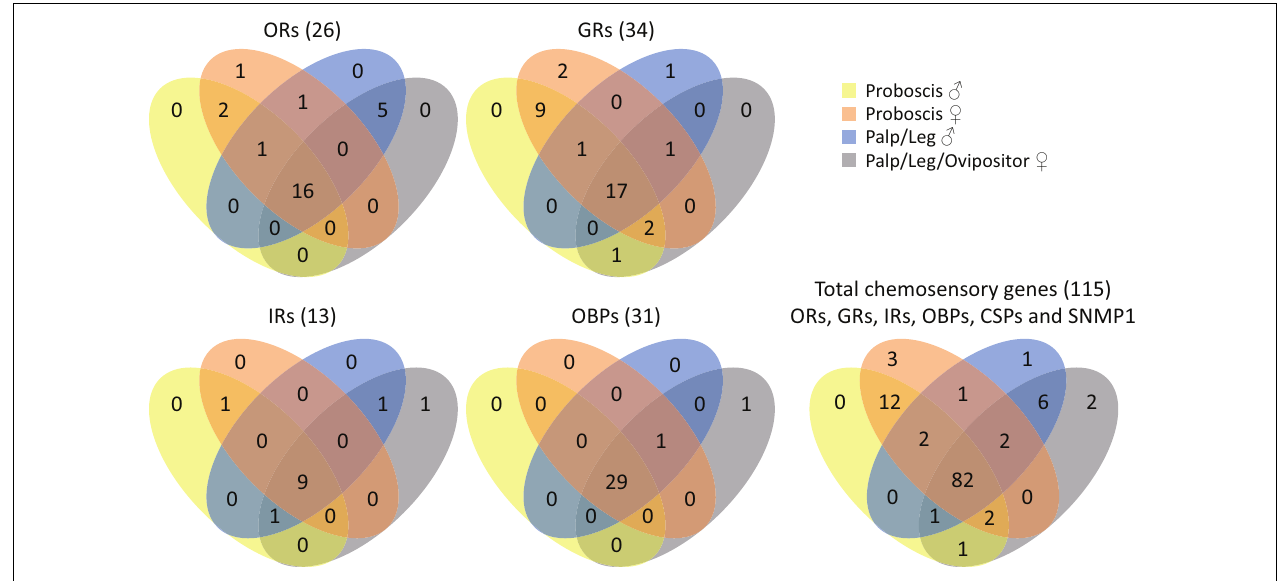
FIGURE 1 | Venn diagrams showing the expression of chemosensory transcripts in the different tissues and